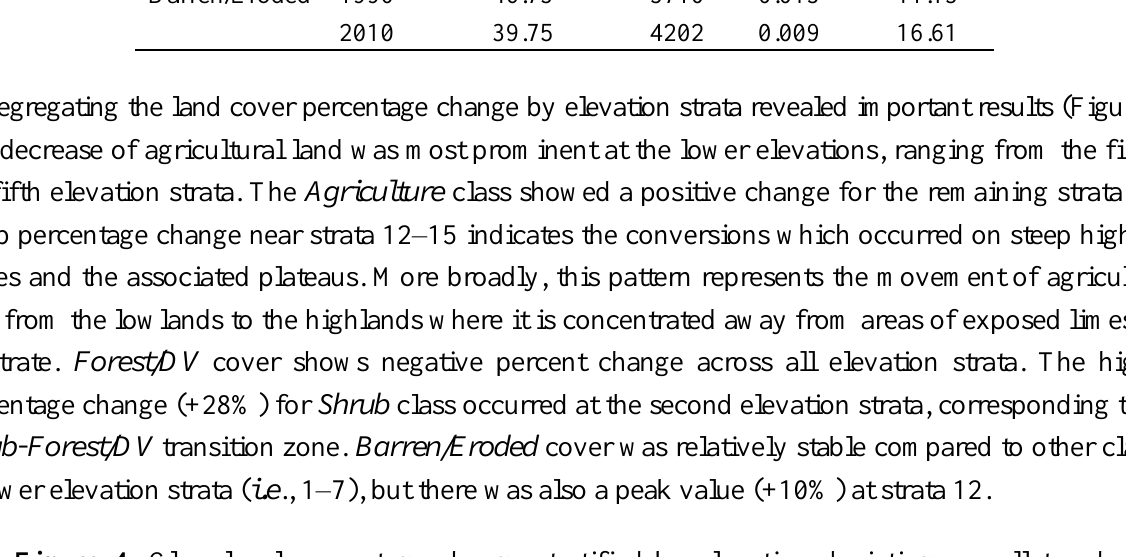
Figure 4. Class-level percentage change stratified by elevation depicting overall trends from base elevations to island